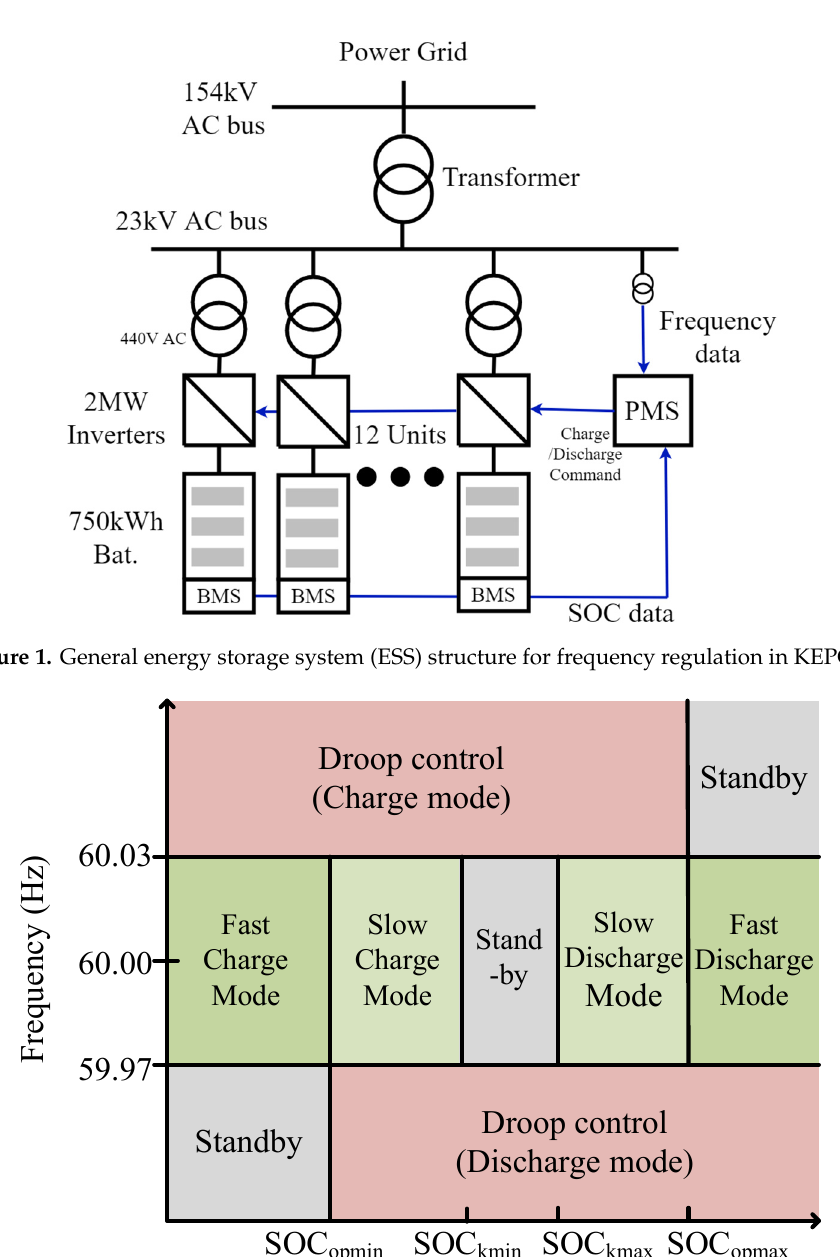
Table 1. frequency regulation (FR)-ESS operating parameters.